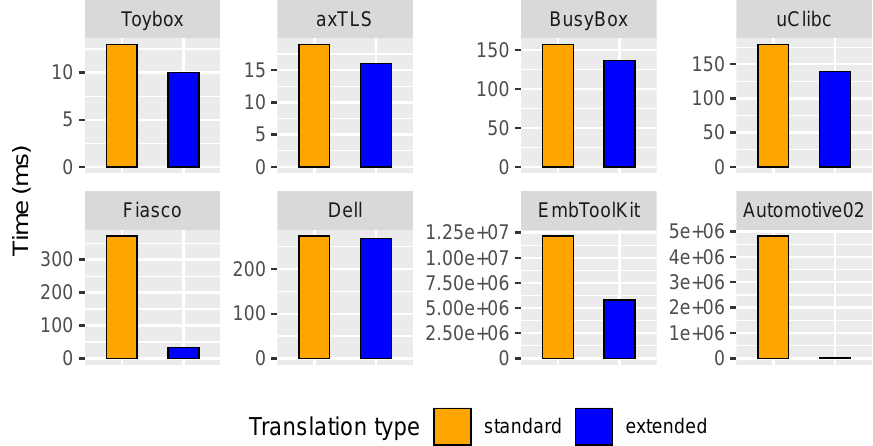
Figure 12. BDD build times for standard and extended logic